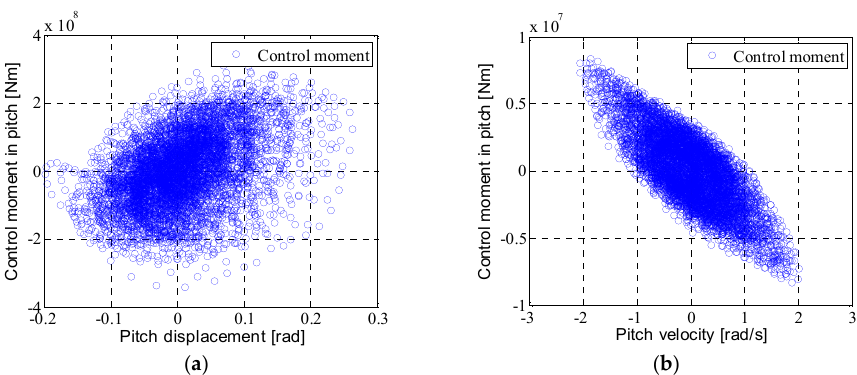
Figure 18. ( a ) The relation between the control force in the heave motion from the THPEH system and the heave displacement of the platform; ( b ) the relation between the control force in the heave motion from the THPEH system and the heave velocity of the platform.